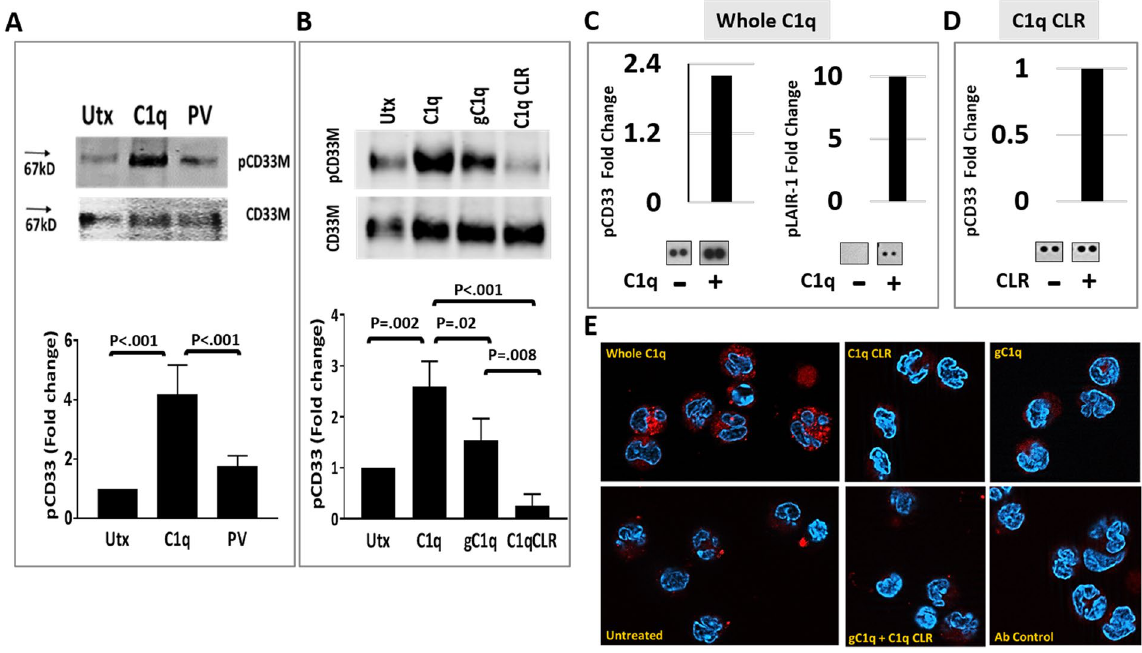
Figure 3. C1q triggers CD33 ITIM phosphorylation and CD33-LAIR-1 physical associations in human monocytes. Monocytes were either untreated (utx), treated with whole C1q, gC1q, C1q CLR or pervanadate (PV) as detailed in Materials and Methods. ( A , B ) Immunoblot analyses showing increased phosphorylated (p) CD33 after treatment with C1q and gC1q, but not C1q CLR. CD33 was immunoprecipitated with anti-CD33M antibody; tyrosine phosphorylation of CD33 (pCD33M) was detected with anti-phosphotyrosine (4G10) antibody. The membrane was stripped and re-probed with anti-CD33 WM53 antibody (CD33M). Arrows denote molecular weight of 67kD. Bar graphs denote pooled data expressed as fold change relative to total CD33 and corresponding statistical analyses. One-way ANOVA with post-hoc Tukey multiple comparisons was used to determine significance. N = 4 for A; N = 3 for B. ( C ) The addition of whole C1q (20 ug/ml) prompts concurrent increases in pLAIR-1 and pCD33 in a phospho-immunoreceptor array. ( D ) C1q CLR “tails” (20 ug/ml) do not elicit increases in pCD33M in the phospho-immunoreceptor array. Bar graphs represent fold change (plus/minus C1q), calculated from the mean pixel density of duplicates, as determined by densitometry analysis. Corresponding C1q minus/plus array data is located below each bar graph in C and D. Data from a typical array are shown. N = 3 for C and D. ( E ) Proximity ligation assay, performed on freshly isolated human monocytes as detailed in materials and methods, showing that whole C1q is required for CD33-LAIR-1 crosslinking. Red fluorescent dots represent molecular associations between CD33 and LAIR-1; blue represents nuclear staining with DAPI. CLR and gC1q represent the C1q collagen tail and globular heads of C1q, respectively. Original magnification = 60X. One of three representative experiments is